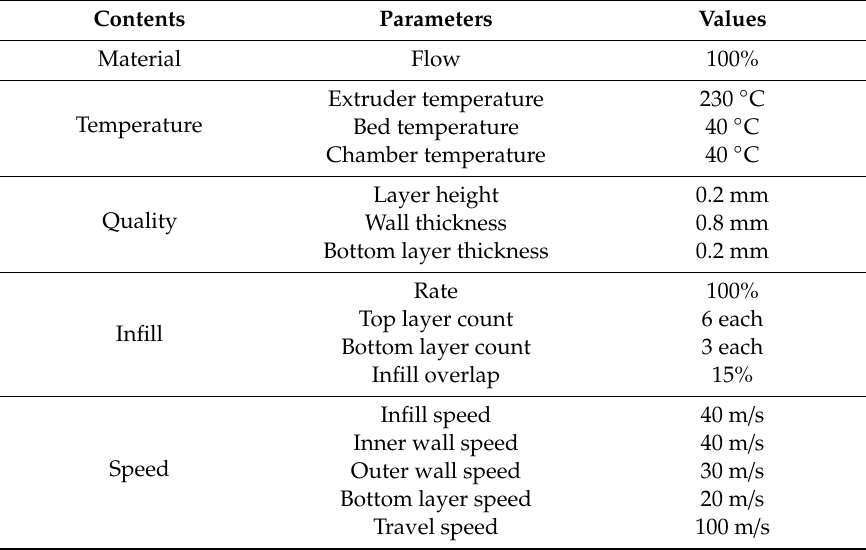
Table 3. Conditions of additive manufacturing.